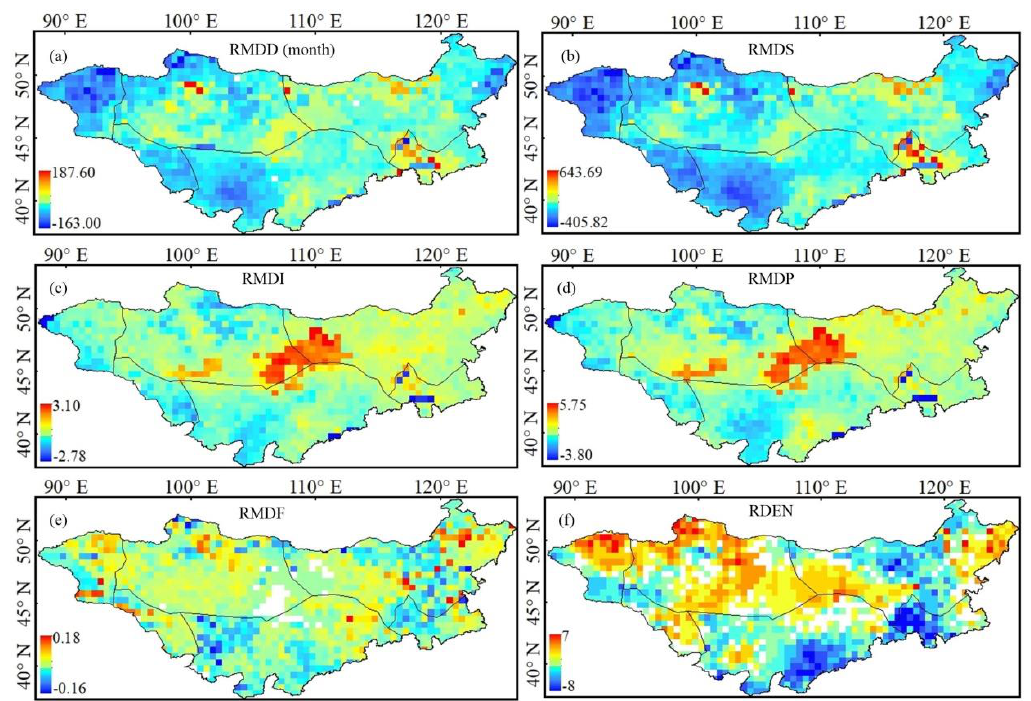
Figure 8. Spatial pattern of the relative differences in the drought events before and after the abrupt change (1959–1995 and 1996–2018). ( a ) RMDD, ( b ) RMDS, ( c ) RMDI, ( d ) RMDP, ( e ) RMDF, ( f ) RDEN.